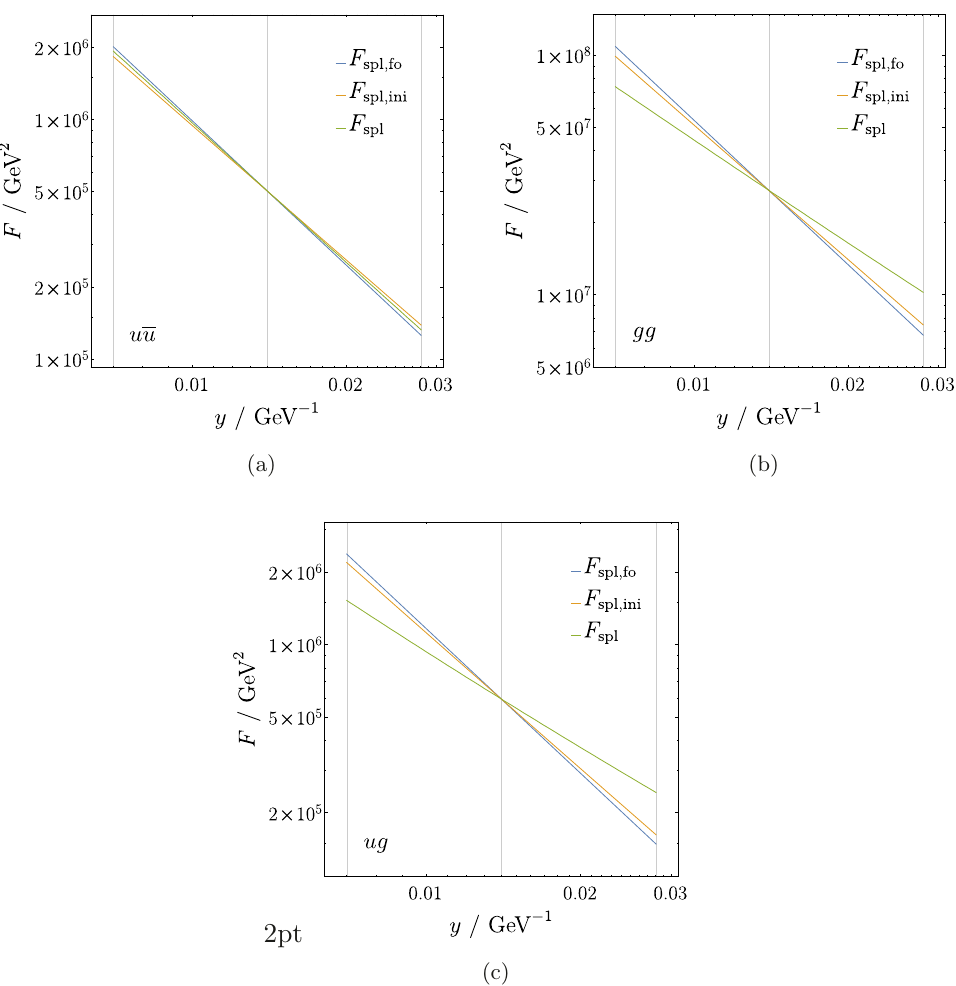
Figure 14 . Splitting DPDs F spl as a function of y , with x 1 = x 2 = 5 . 7 The parton combinations shown are u ¯ u (a), gg (b) and ug (c). The vertical grey lines correspond to y = b 0 / (160 GeV), y = b 0 / (80 GeV) and y = b 0 / (40